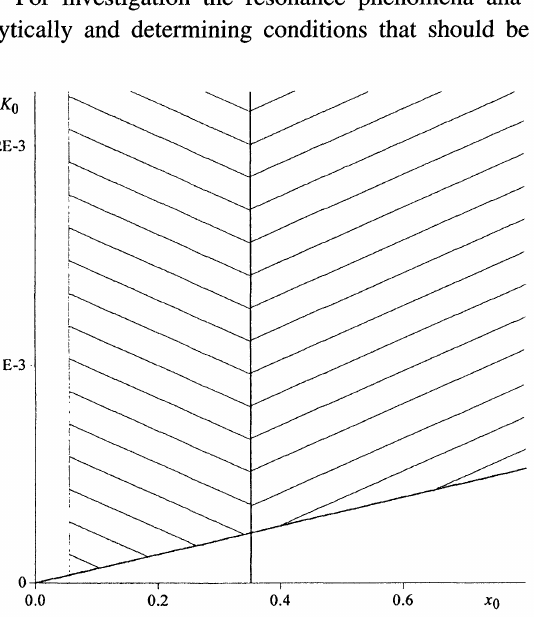
FIGURE 7 Division of the (Xo, Ko) plane by theoretical curves in one-dimensional-plane case. Theoretical lines are shown by the following colors: L is red, L2 is blue, L is light green. The model parameters used in calculations are given in Table